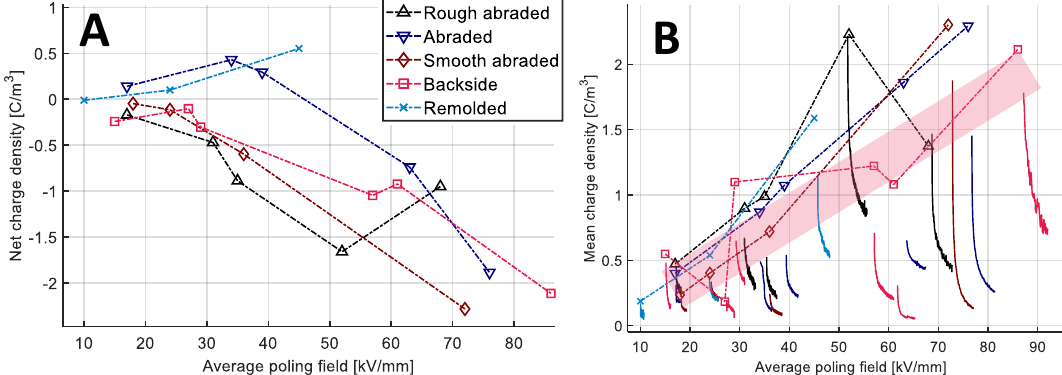
Figure 8. Impact of mean poling field at 25 ◦ C on net charge density (( A ), left) and mean charge density (( B ), right). The indicated surface types are used as positive anode, while the cathode is a backside type surface in all experiments. The markers indicate the value in the end of the polarization. The solid lines in ( B ) show the mean charge density against time during depolarization. Dashed lines indicate trendlines. The pink shaded area in ( B ) indicates the trend for backside surfaces, which can be treated as reference.